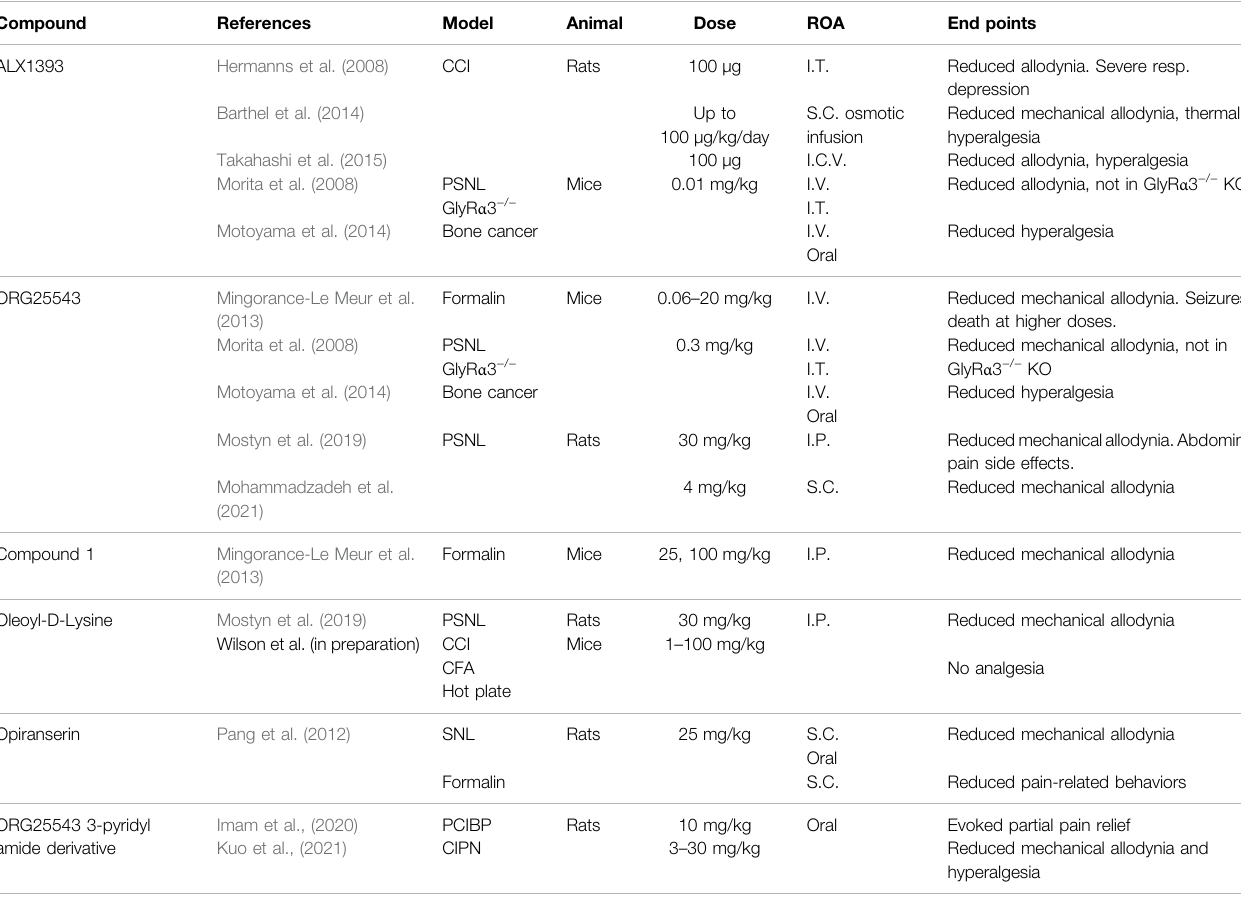
TABLE 2 | Experiments investigating known GlyT2 inhibitors. I.C.V., intracerebroventricular.